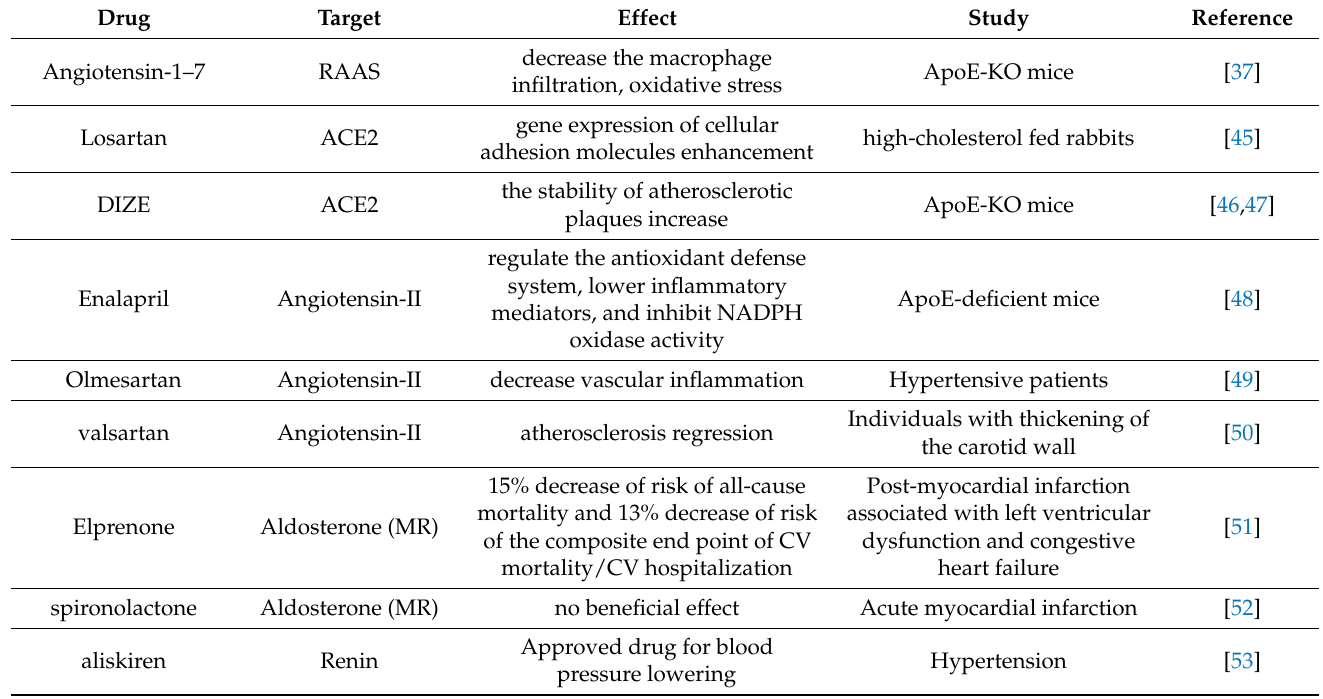
Table 1. Targeting various elements of the RAAS system in the therapy of cardiovascular disorders.